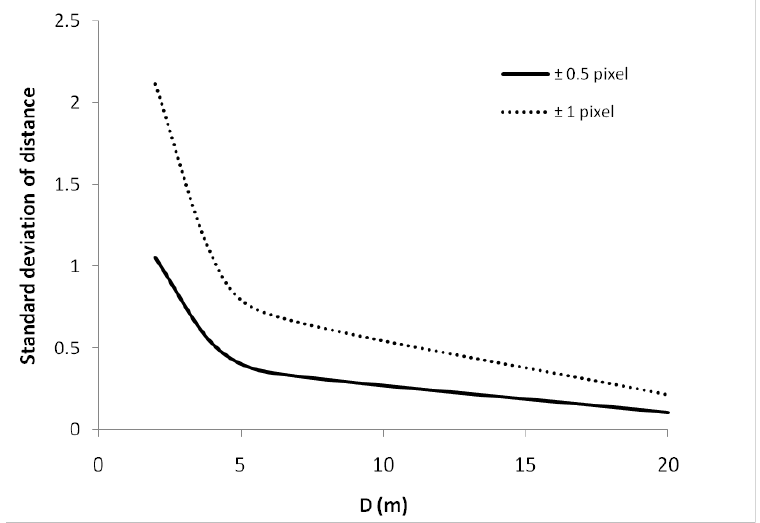
Figure 11. Relationship between baseline length D and the standard deviation of the calculated distance for pixel deviations of 0.5 and 1 pixel. The standard deviation decreases with increasing distance D and is larger for a larger pixel